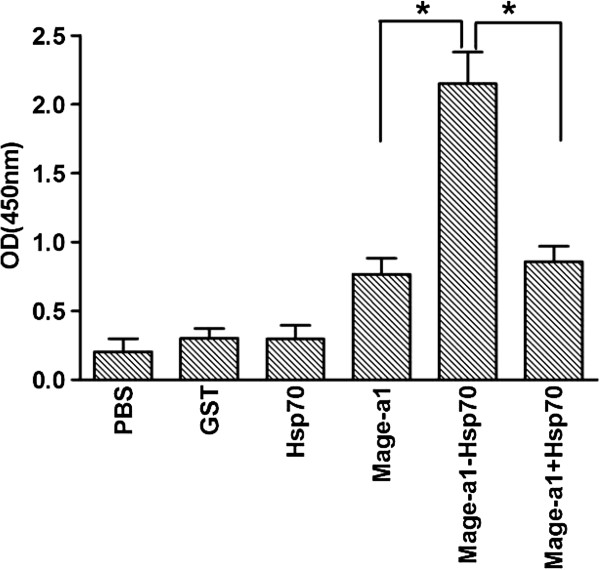
Humoral immune response after vaccination with Hsp70-Mage-a1 fusion protein. Purified GST, Hsp70, Mage-a1, Mage-a1-Hsp70 fusion protein or a combination of Mage-a1 + Hsp70, were diluted to a concentration of 200 pmol. Mice were immunized sub-cutaneously with a PBS control or 0.2 ml of each protein, followed by a booster injection after one week. Serum samples were obtained two weeks after the booster. The levels of anti-Mage-a1 antibody were examined by ELISA. The means ± SE of the absorbance (A540 nm) of three separate experiments are presented at 1:50 dilution. Statistical analysis by one-way ANOVA showed that mice vaccinated with Mage-a1-Hsp70 had significantly higher titers of anti Mage-a1 antibody than Mage-a1 or Mage-a1 + Hsp70 (* p < 0.001).